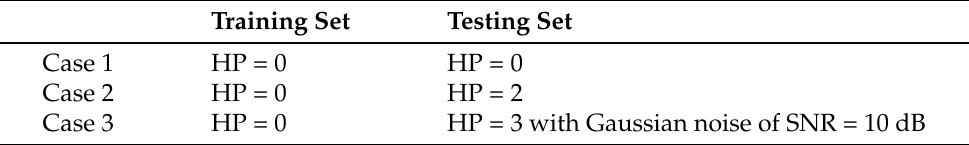
Figure 7. Diagnosis accuracy of multi-class imbalance fault dataset under variant Motor load: ( a ) SVM model; ( b ) BP model; ( c ) DBN model and ( d ) CNN model. Table 3. The dataset partitioning for imbalance fault diagnosis under variant motor load and noise.